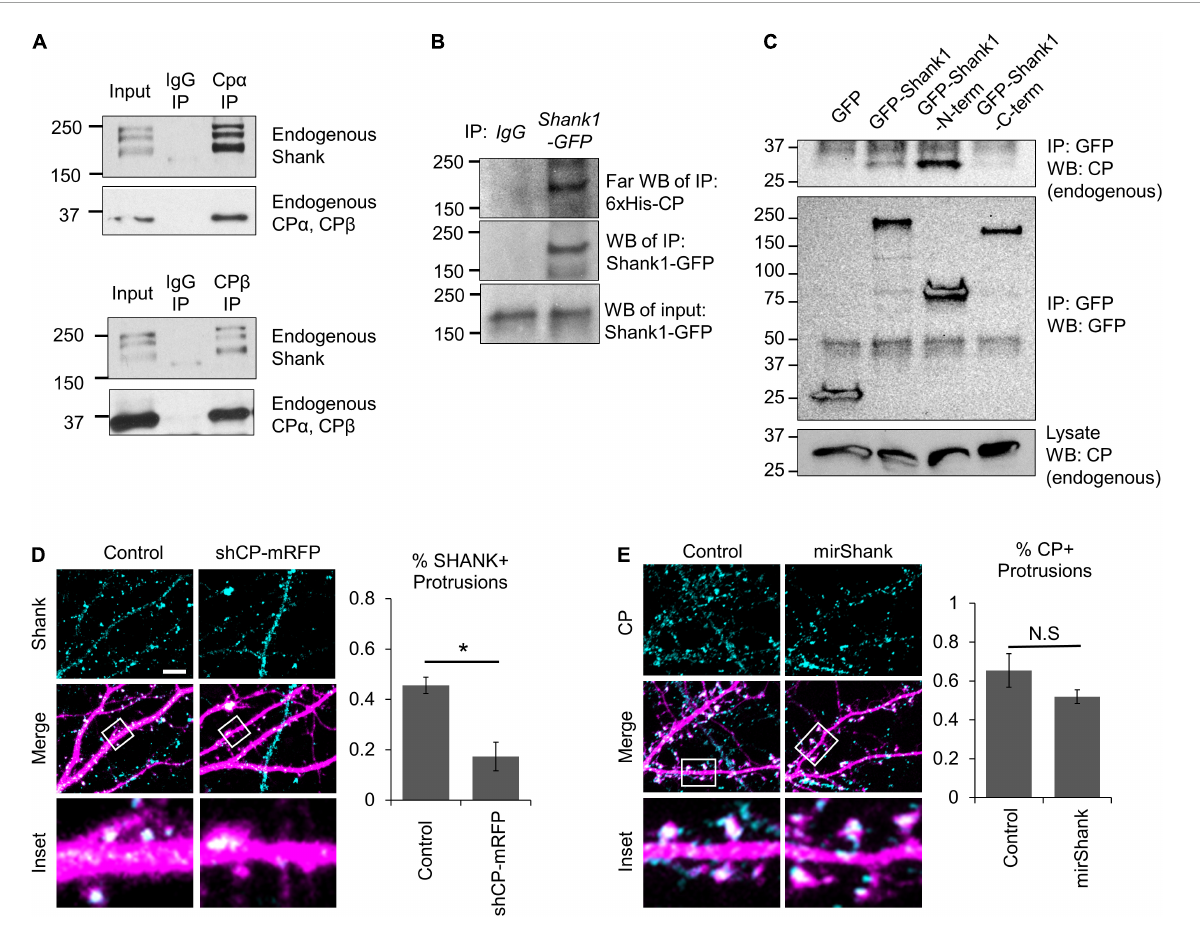
FIGURE7 Capping protein (CP) association with Shank scaffolding proteins. (A) Co-IP of endogenous Shank proteins with endogenous CP from isolated adult rat hippocampi using two separate antibodies, against either CP α or CP β . (B) Far-western blots showing that purified recombinant 6xHis-CP directly associates with Shank1-GFP from Cath.-a-differentiated (CAD) cell α -GFP immunoprecipitation (IP). (C) Endogenous CP co-IPs with GFP-Shank1 from CAD cell lysates. A N -terminal fragment of Shank1 (containing the SPN domain, Ankyrin repeats, and SH3 domain) associates with CP, while the C-terminal fragment (containing the PDZ domain, Proline-rich motifs, and SAM domain) does not. (D) Left, representative images of DIV21 hippocampal neurons expressing mRFP (control) or shCP-mRFP (magenta) and stained for endogenous Shank (cyan). Right, CP knockdown significantly reduced the percentage of spines containing Shank puncta, as compared to control cells. N = 14 cells per condition. (E) Left, representative images of DIV21 hippocampal neurons expressing mirScramble-GFP (control) or mirShank-GFP (magenta) and stained for endogenous CP (cyan). Right, Quantification shows no effect of Shank knockdown on the percentage of spines containing CP puncta, relative to control neurons. N = 18 cells per condition. Scale bar, 5 µ m. Error bars represent SEM. * P < 0.05; Mann–Whitney